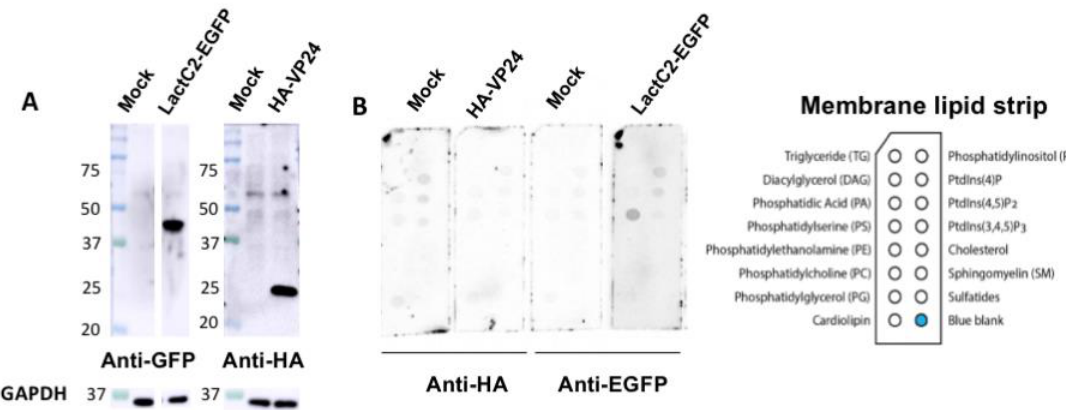
Figure 2. VP24 expressed in HEK293 cells did not bind to lipids. ( A ). The expression of LactC2-EGFP and HA-VP24 were confirmed by Western blot. ( B ). The 80 μg/mL of cell lysate expressing indicated proteins was incubated with membrane lipid strips overnight at 4 °C. The cell lysate of HEK 293 cells with mock transfection was used as a control. HA-VP24 did not bind to any lipids while LactC2-EGFP bound to PS as expected.